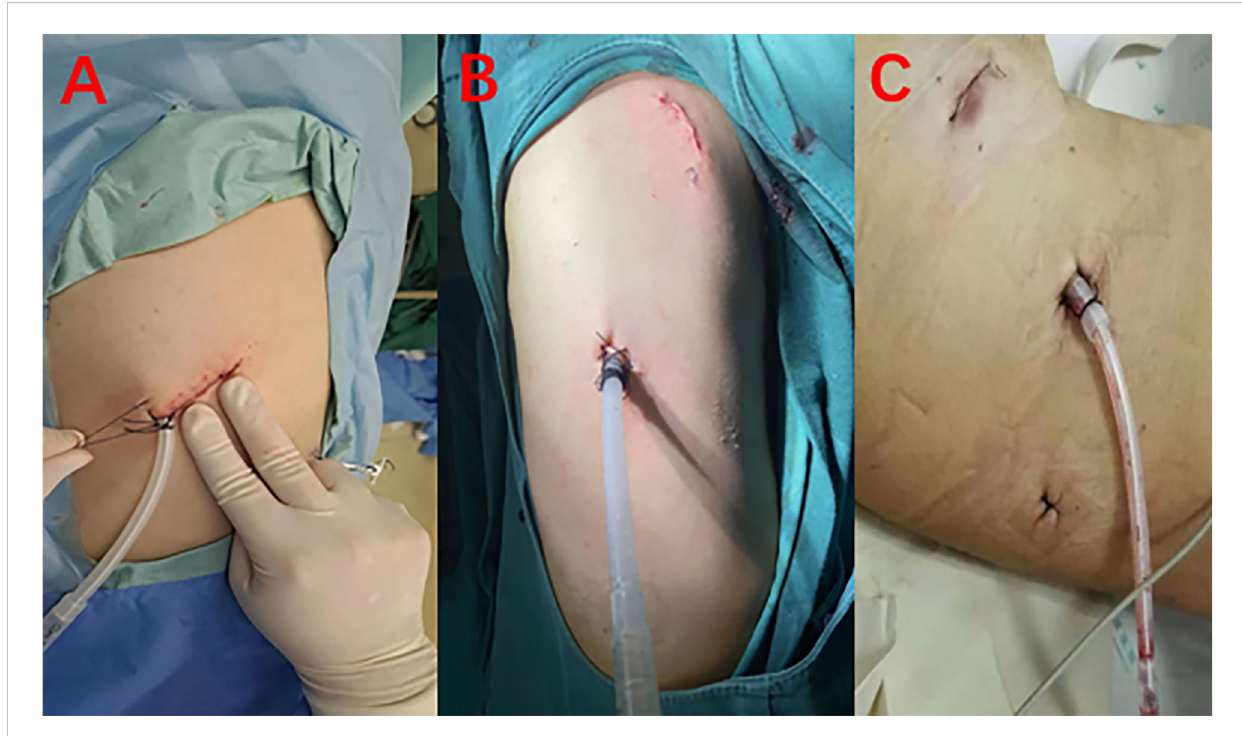
FIGURE 2 (A) Uniportal VATS. (B) Biportal VATS. (C) Triportal